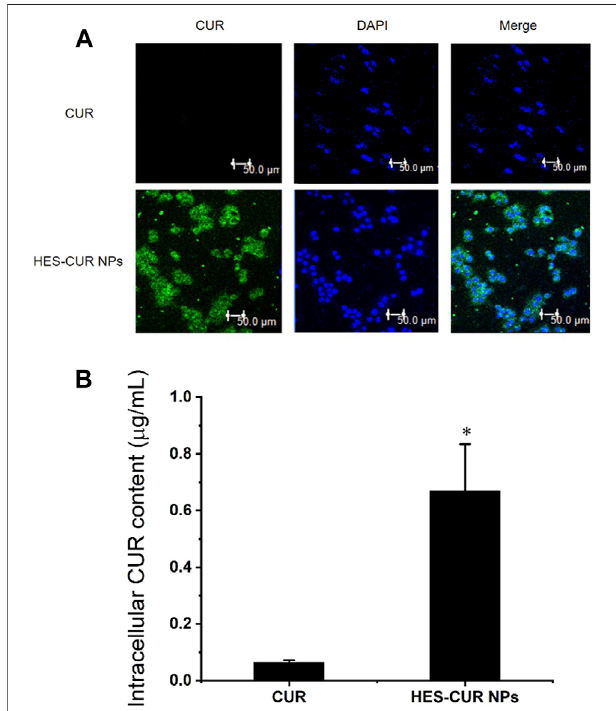
FIGURE 4 | In vitro cellular uptake of CUR. (A) CLSM images of HepG2 cells incubated with CUR and HES-CUR NPs for 4 h, respectively. (B) Intracellular CUR content measured by HPLC. Data were expressed as mean ± SD, and the experiments were repeated thrice. * p < 0.05, compared to the